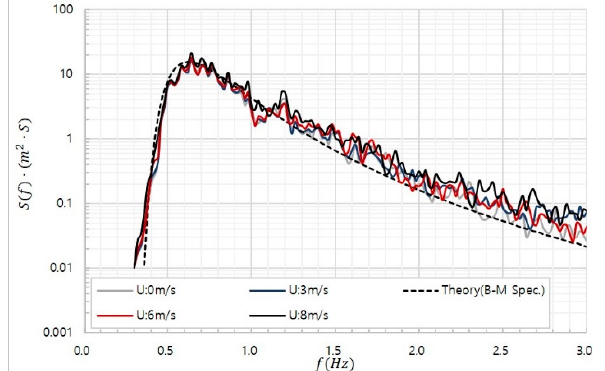
Figure 3. Wave spectrum with wind velocity variation before beach profile installation.